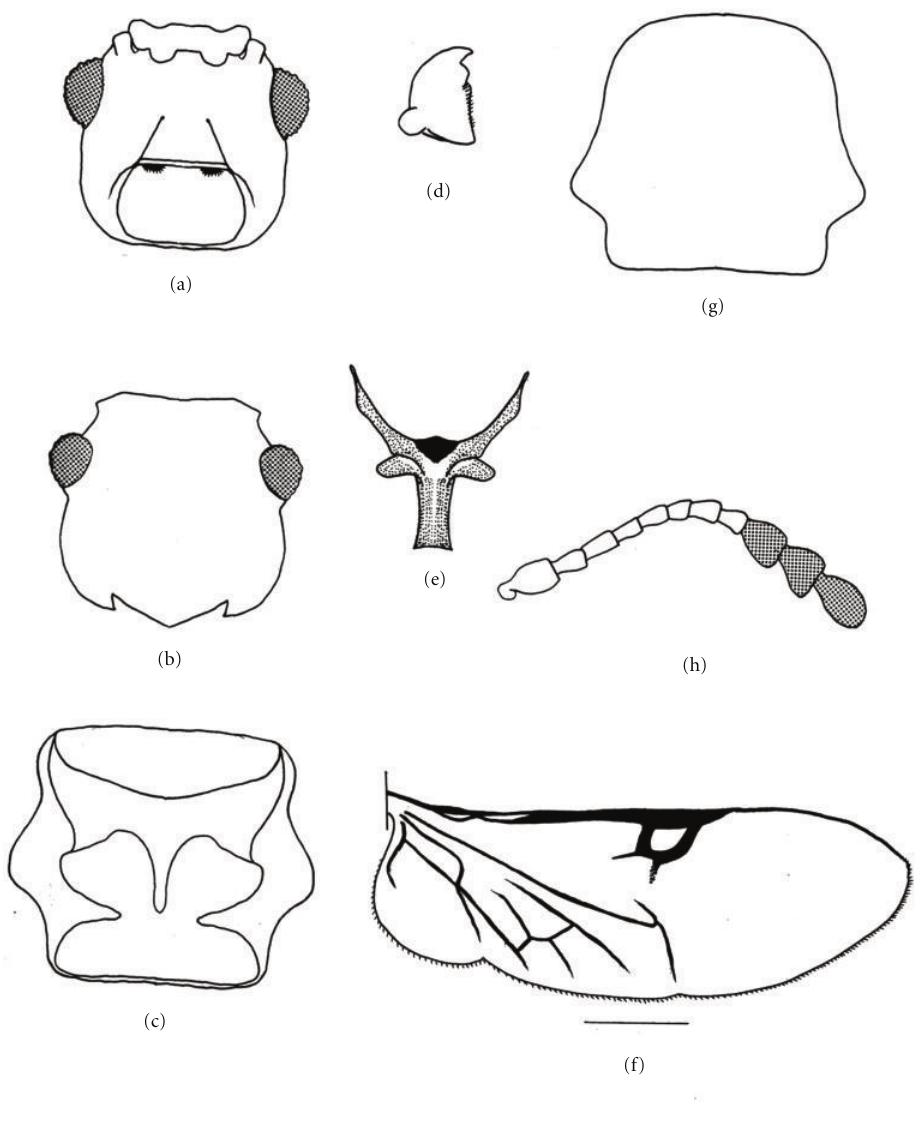
Figure 5: Various organs of Apteropilo chrysocome . (a, b) Head ((a) ventral, (b) dorsal). (c) Pronotum (ventral). (d) Mandible. (e) Metendosternite. (f) Metathoracic wing. (g) Pronotum (dorsal). (h) Antenna.